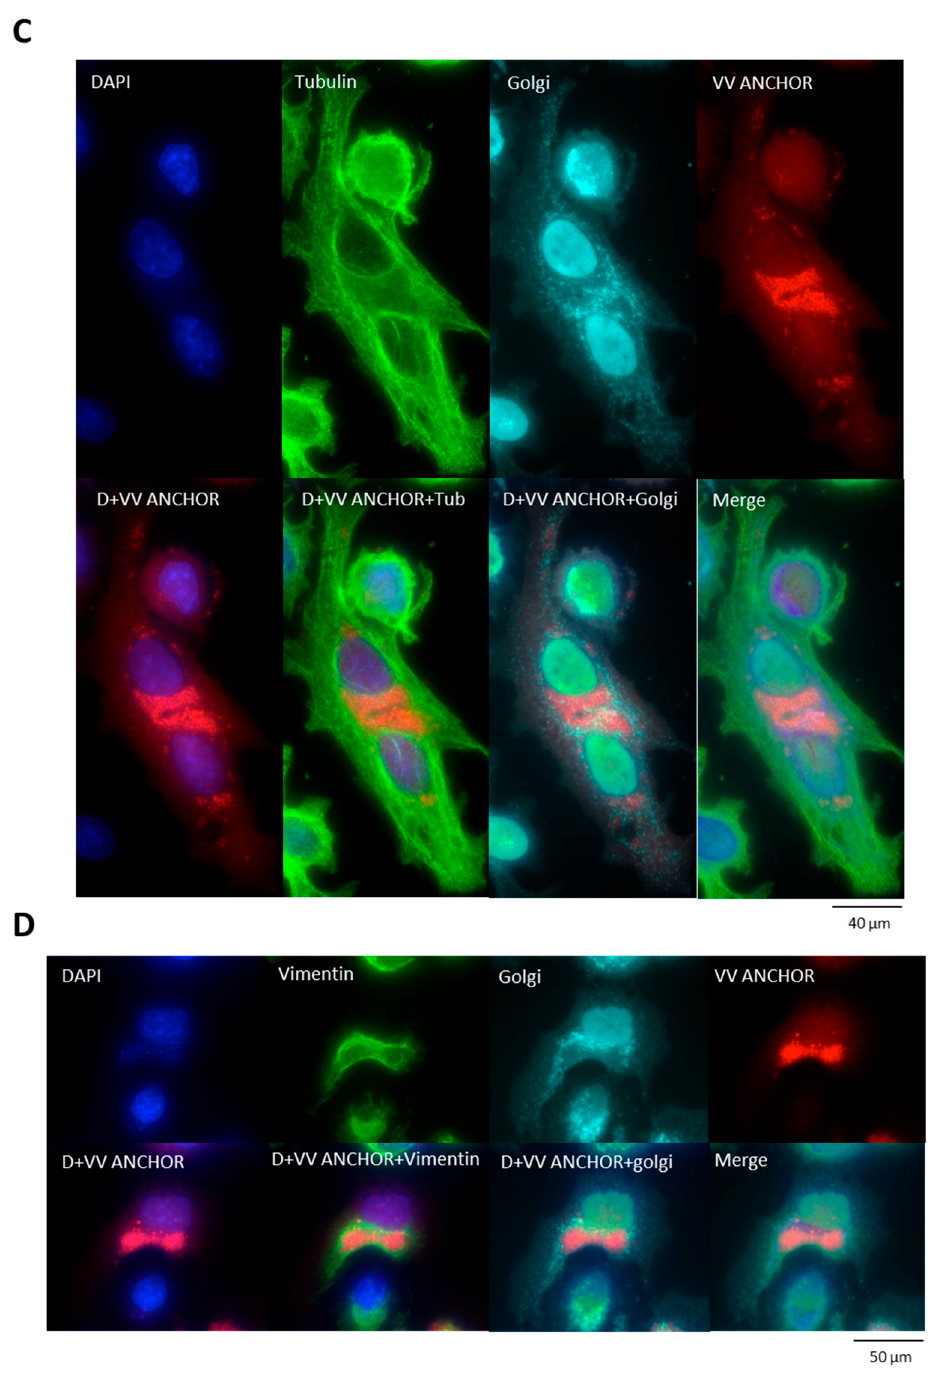
Figure 3. Correlation between VACV ANCHOR infection and the accumulation of markers of interest by immunofluorescence. ( A ) HeLa cells were infected at MOI 1 and fixed with formalin 24 h post-infection. Cells were stained with Hoechst 33342 to visualize DNA. Images are a max projection of A 10 frame Z-stack spaced by 0.5 µ m. Nuclear DNA is stained in blue and VACV DNAs are indicated in red. ( B ) As in A , but cells were processed for immunofluorescence against lamin A / C. A far-red Lectin GS-II is used to stain the Golgi apparatus. Images are a max projection of A 10 frame Z-stack spaced by 0.5 µ m. Nuclear DNA is stained in blue, lamin in green, golgi in light blue and VACV DNAs are indicated in red. ( C ) As in B , except an antibody against tubulin (green) was used. ( D ) As in B , except an antibody against vimentin (green) was used.